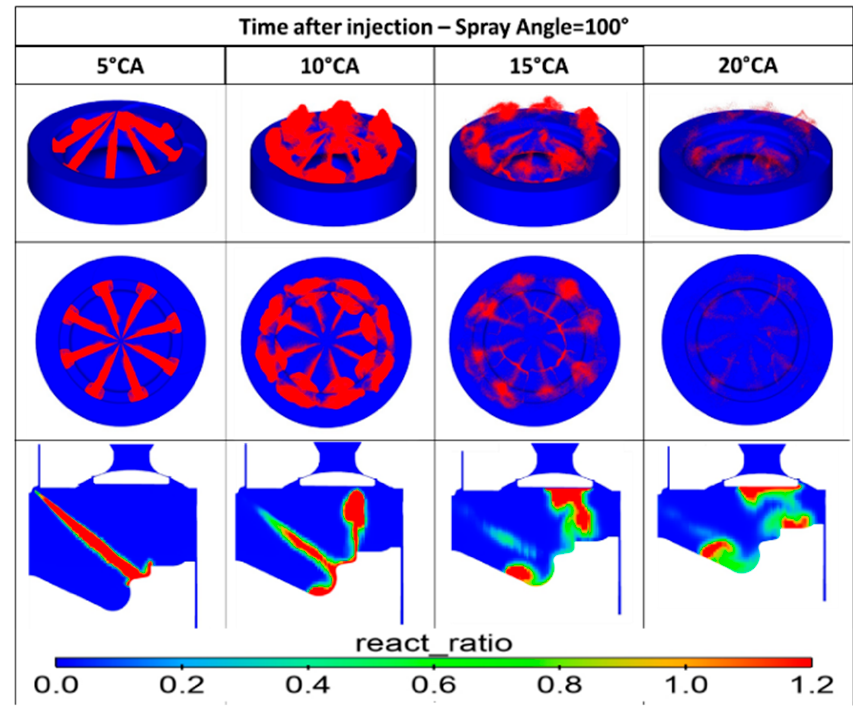
Figure 32. For an SIA of 100°, spray penetration in oblique side and top views and RER contour plot in a planar section through the cylinder axis and a spray axis.